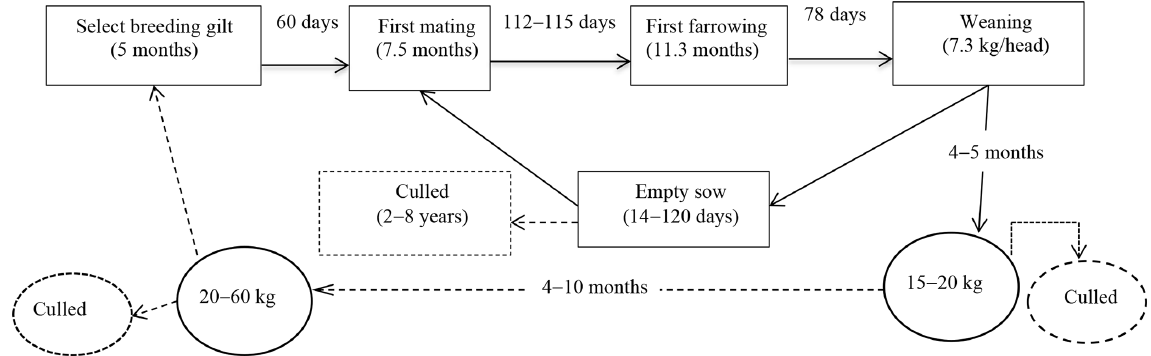
Figure 2. Indigenous pig reproductive and productive cycle. AFM: age of first mating (month).